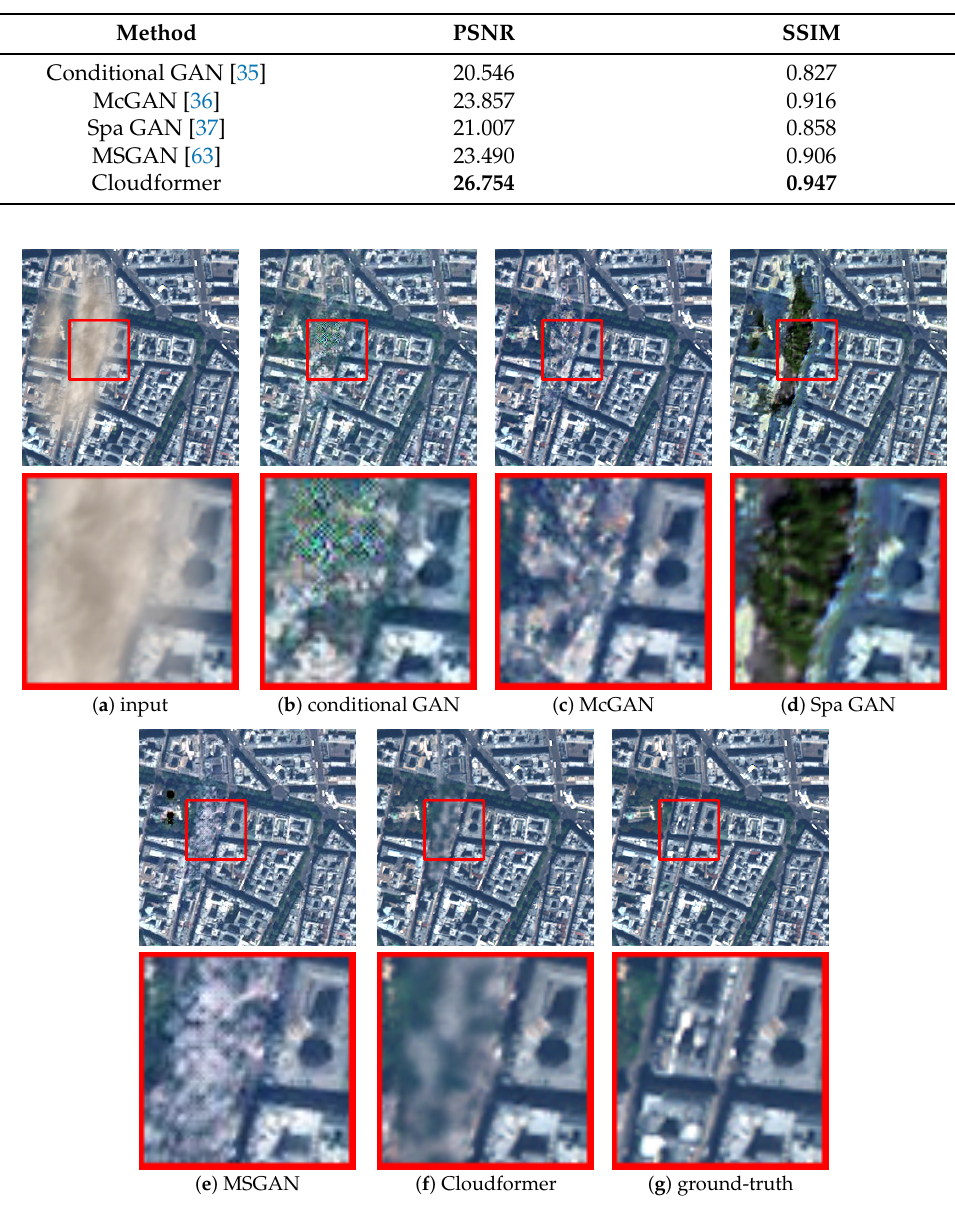
Figure 15. Comparative experimental results on first sample of Paris dataset. The result of Cloud- former is closer to the ground-truth than the other compared methods in both texture and